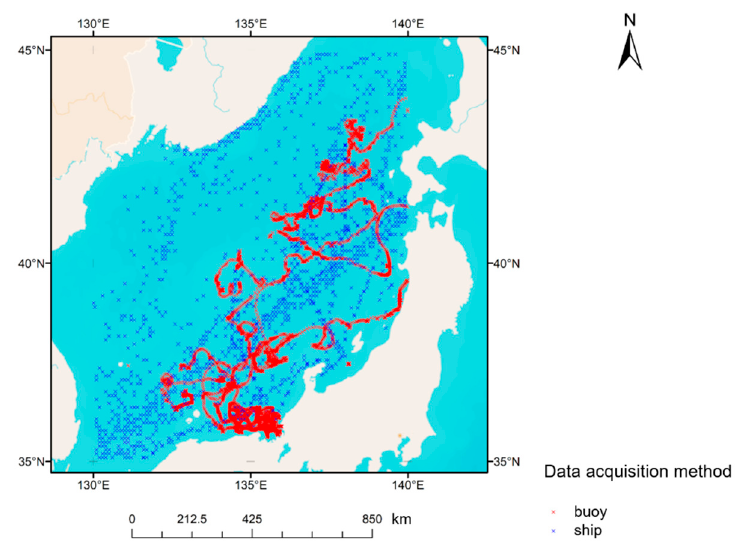
Figure 1. Space distribution of measured SST in NEAR-GOOS database.